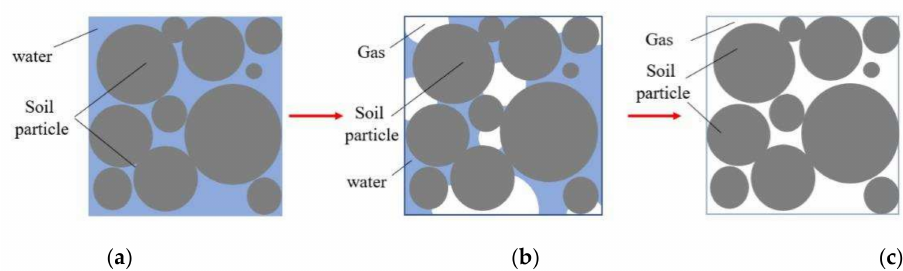
Figure 9. Diagram of water evaporation between soil particles. ( a ) Saturation state, ( b ) Unsaturated state (water-gas-particle interface), ( c ) Drying state.